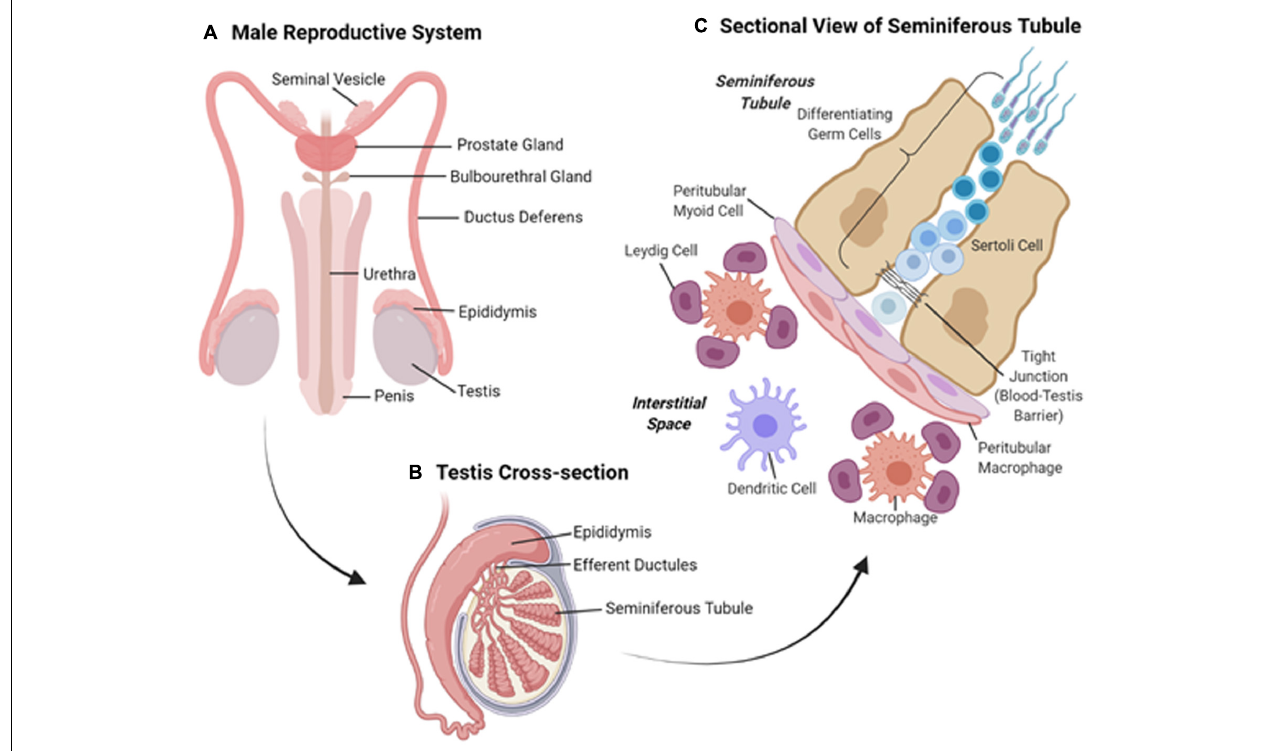
FIGURE 1 | (A) Overview of the tissues comprising the human male reproductive system. (B) Schematic diagram of a cross-section of the test is showing the coiled seminiferous tubules and adjoining epididymis. (C) Sectional view of the cells comprising the seminiferous tubules and surrounding interstitium.